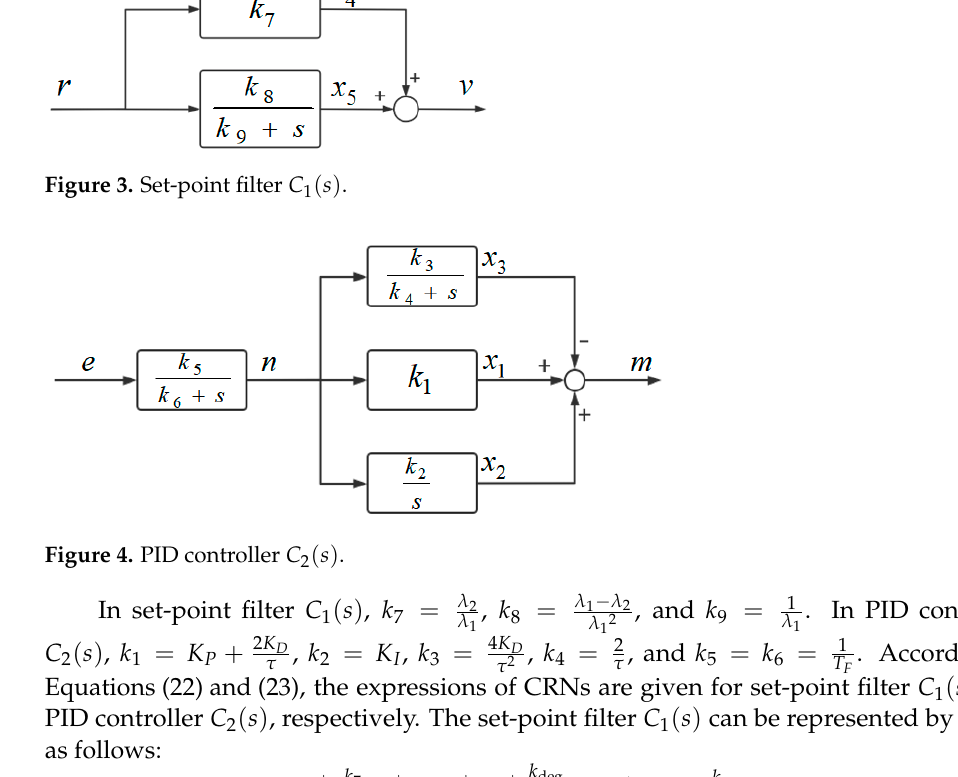
. According to ( ) C s 1